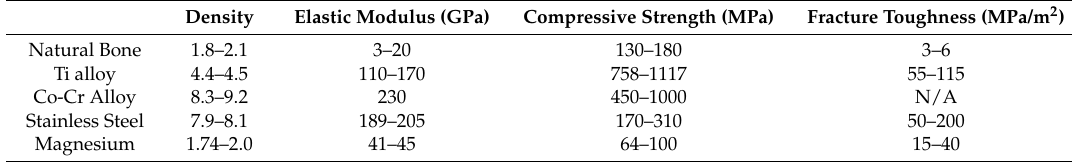
Table 1. Mechanical properties of steels and bone. Reproduced from [6]. Copyright 2006, Elsevier.